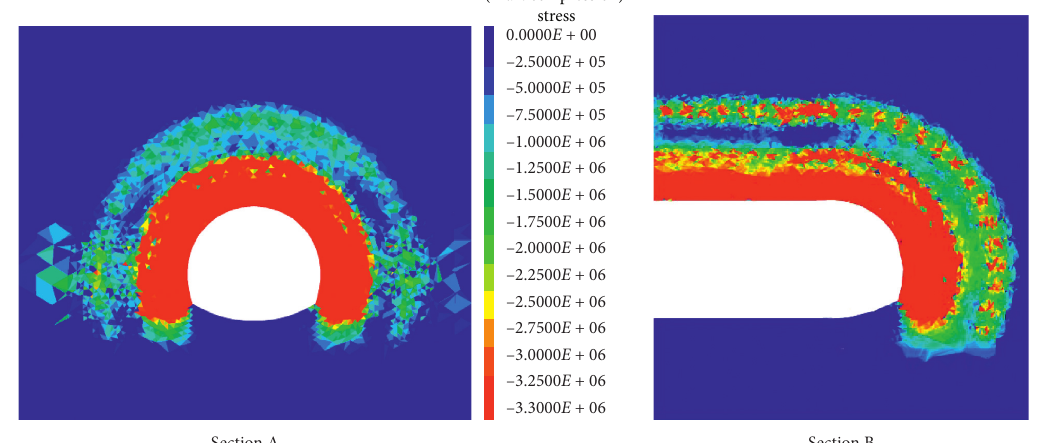
Figure 24: Stress of the surrounding rock under preloading 350kN.